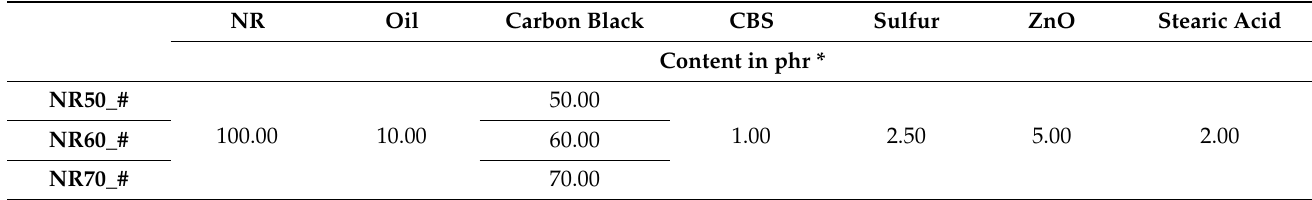
Figure 2. ( a ) Customized nonconductive clamps; ( b ) testing protocol.